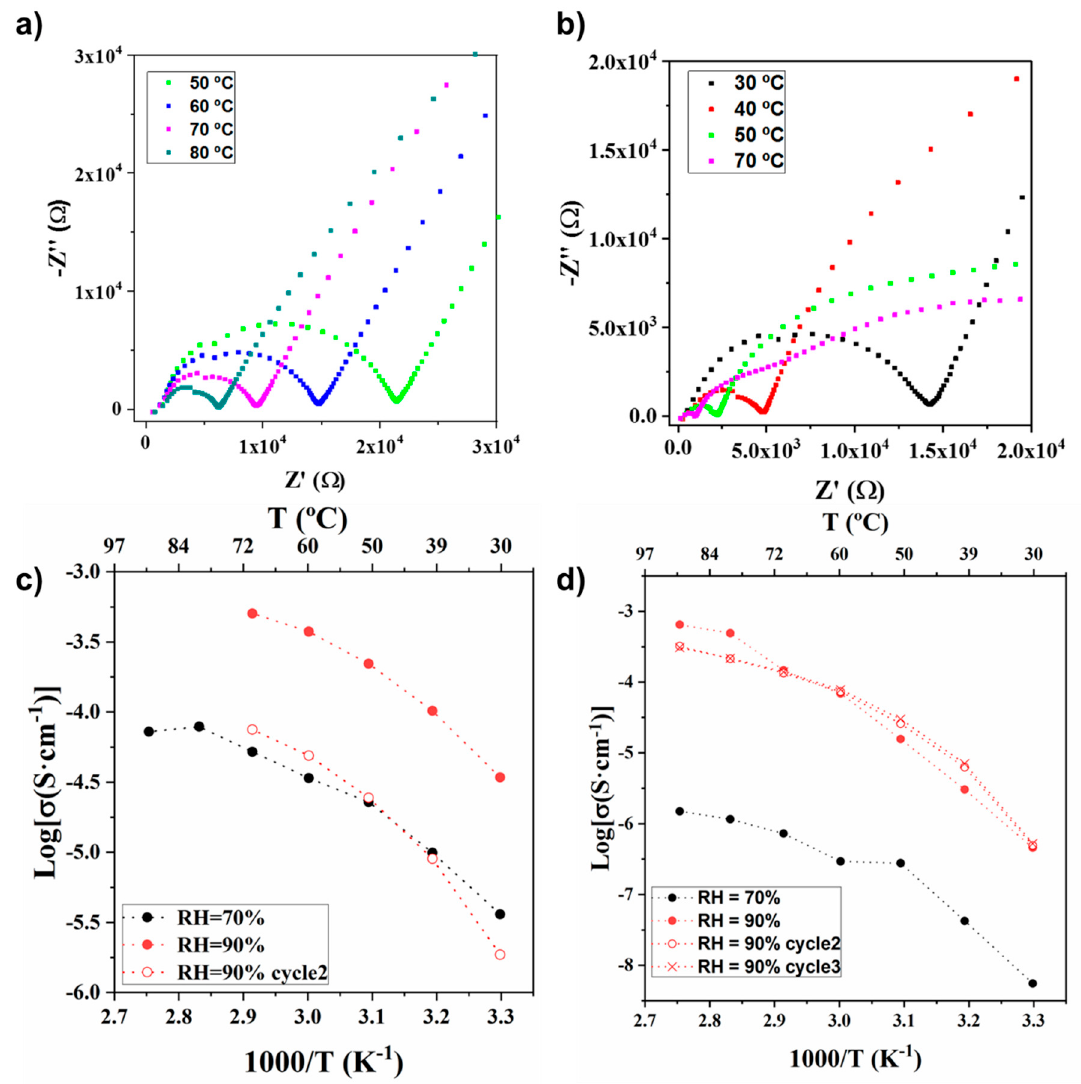
Figure 3. Nyquist plots for UPG-1 collected at 70% RH ( a ) and at 90% RH ( b ) and different temperatures. Arrhenius plots for UPG-1 ( c ) and Lys@UPG-1 ( d ), respectively, exhibiting the evolution of the proton conductivity vs. temperature at 70 and 90% RH. Recyclability of both UPG-1 and Lys@UPG-1 at 90% RH is also represented.